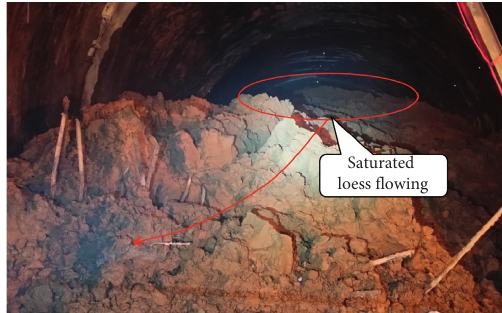
Figure 6: The saturated loess flowing on excavation face.